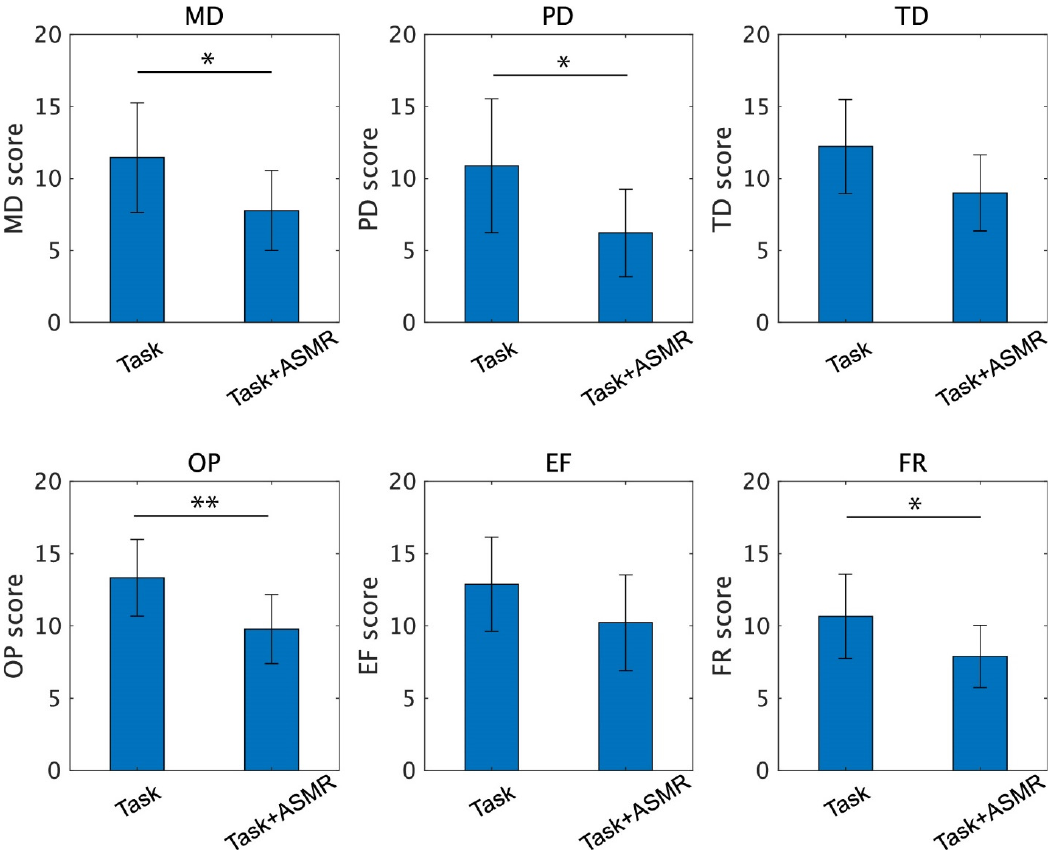
Figure 7. Individual scores of the NASA-TLX for the performance of the mental task without (left) and with (right) application of ASMR sound. Asterisks * and ** indicate p < 0.05 and p < 0.01 as evaluated by Wilcoxon ranked sum test.